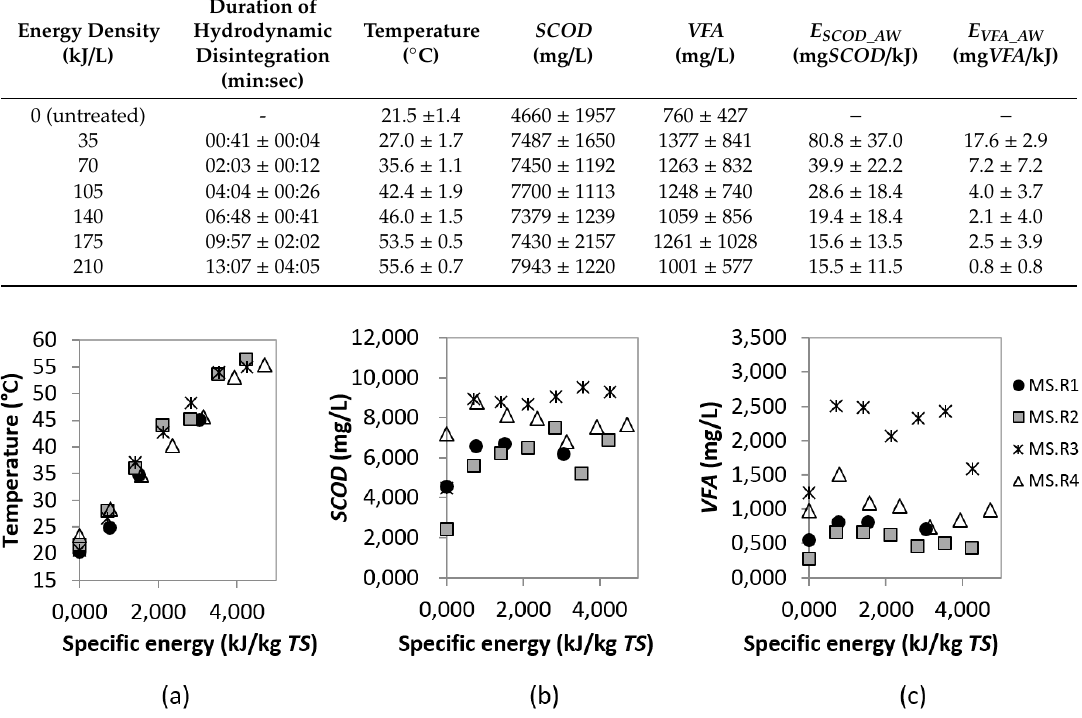
Figure 9. E ff ect of specific energy on: ( a ) Temperature of maize silage; ( b ) SCOD ; ( c ) VFA release from maize silage.